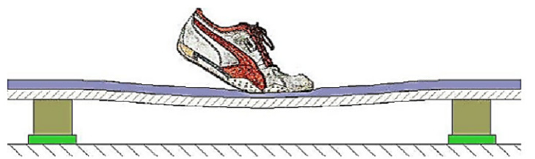
Figure 1. The reaction of an elastic floor to the force exerted by the basketball player.